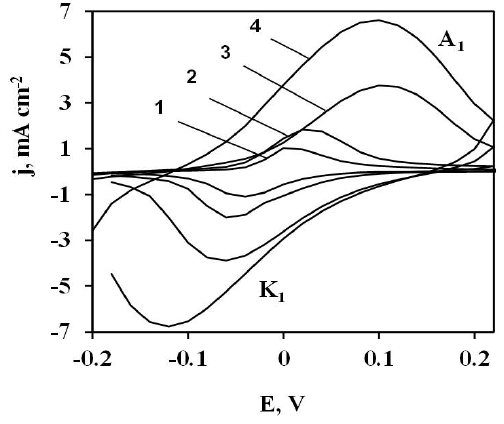
films on AISI 304 type 2